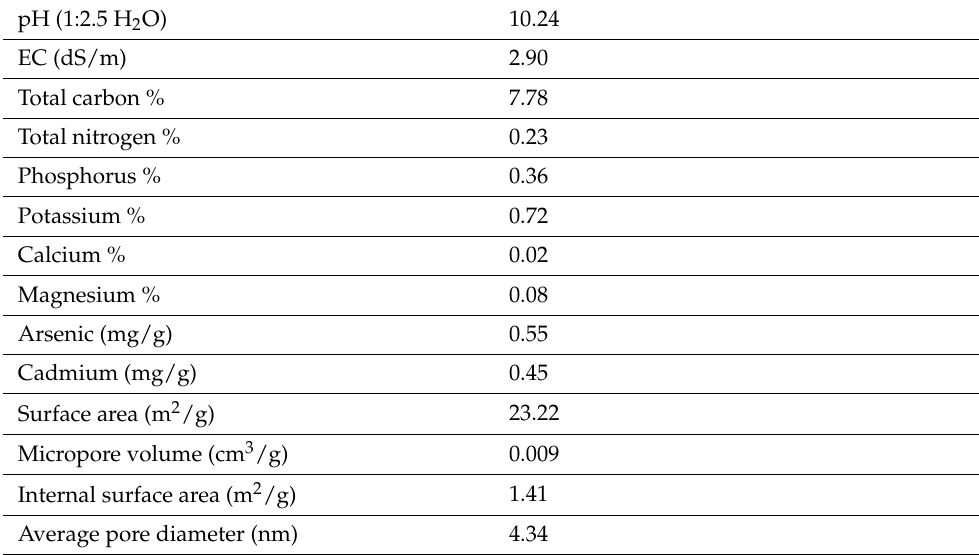
Table 3. The chemical and physical properties of rice-husk-derived biochar